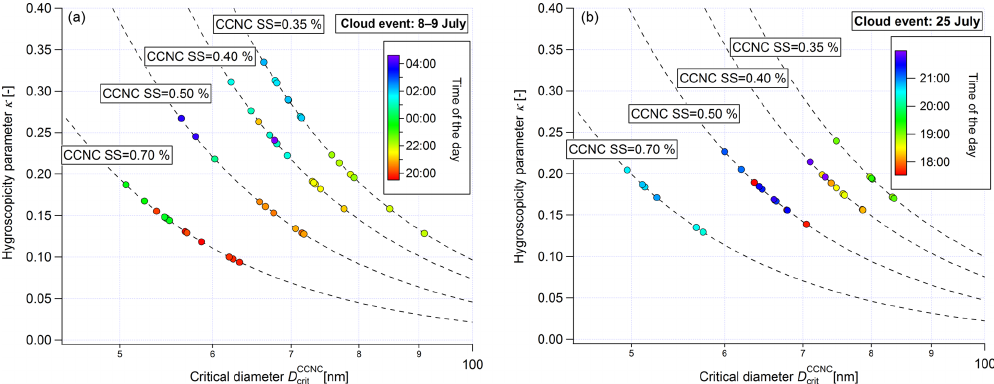
Figure 4. Hygroscopicity parameter as a function of the critical diameter during the (a) 8–9 July and (b) 25 July cloud events. Single dots are data points extracted from a 6min SMPS scan and simultaneous polydisperse CCNC measurement behind the total inlet. The thin dashed lines indicate the theoretical relationships between hygroscopicity and size for the supersaturation applied in the CCNC.